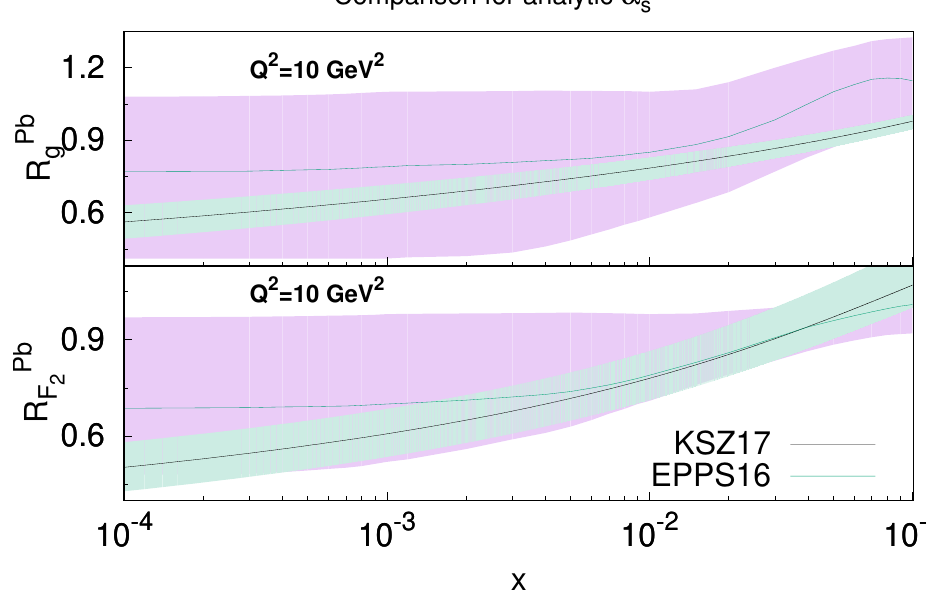
Figure 1. x dependence of R AD ( x ,µ 2 ) and R AD ( x ,µ 2 ) at µ 2 = 10 GeV 2 for lead data. A green line with g F 2 pink band (shows 90% uncertainties) is taken from the second paper of [35], while a black one with light green band is obtained in